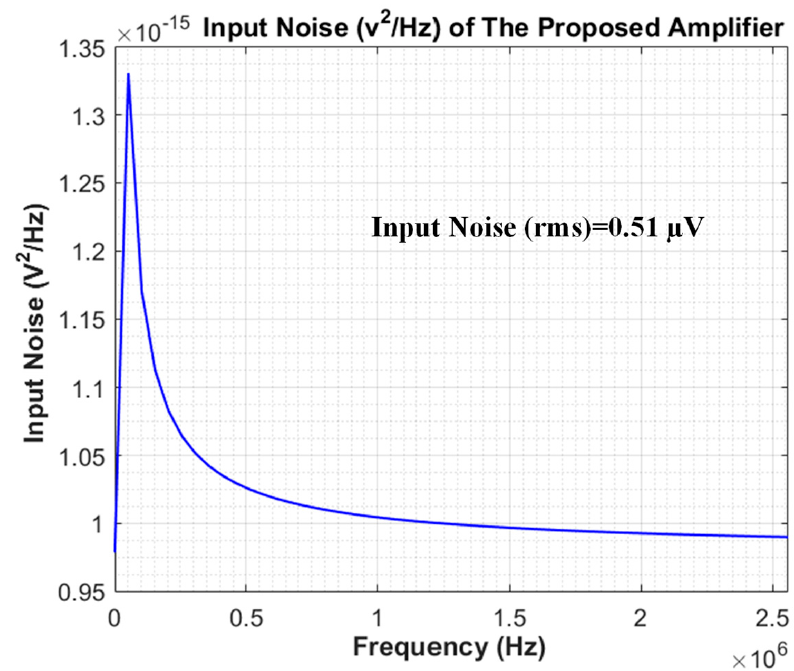
Figure 12. Input noise analysis of the proposed ampli fi er.